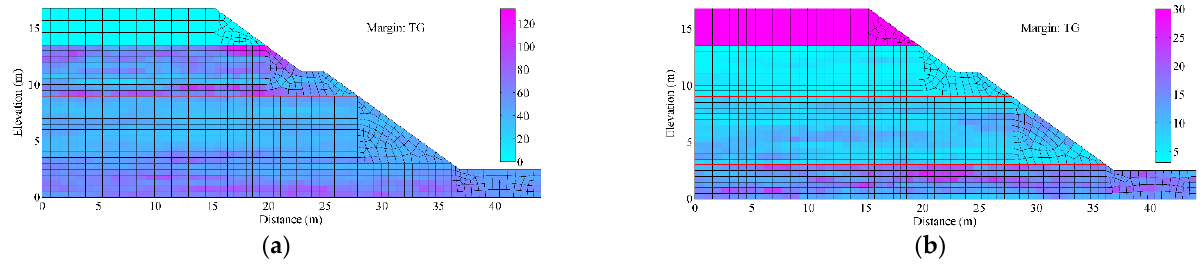
Figure 22. A typical realization of transversely anisotropic CCRF yielded by strategy 6. ( a ) Random field of c. ( b ) Random field of ϕ.